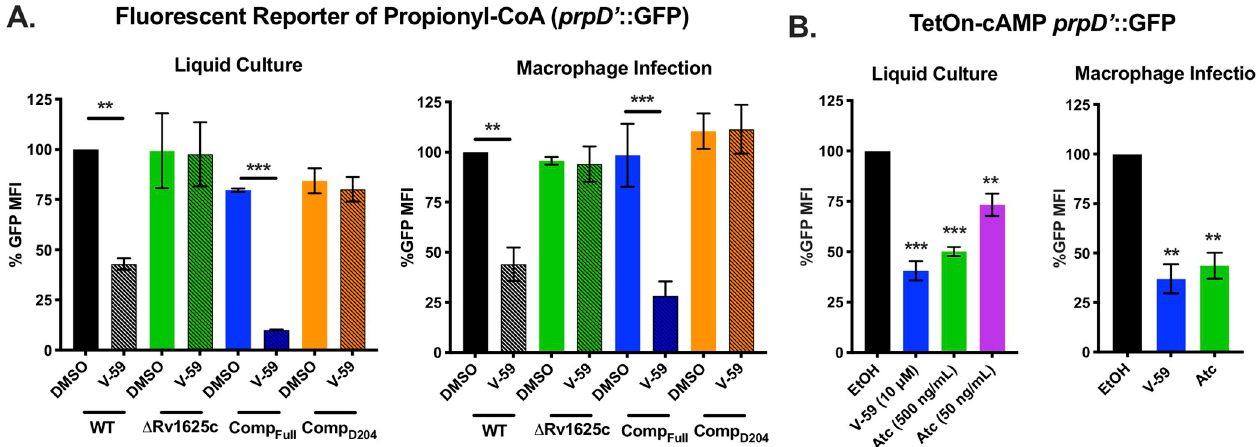
Fig 7. Activating cAMP synthesis decreases liberation of propionyl-CoA from cholesterol. ( A ) Relative GFP signal from the prpD’ ::GFP reporter in response to V-59 (10 μ M) or DMSO treatment in murine macrophages or cholesterol media. Data are normalized to WT treated with DMSO ( �� P < 0.01, ��� P < 0.001, Two-way ANOVA with Tukey’s multiple comparisons test). ( B ) Relative GFP signal from the prpD’ ::GFP reporter in response to inducing TetOn-cAMP with Atc treatment in murine macrophages or cholesterol media. Data are normalized to EtOH vehicle control ( �� P < 0.01, ��� P < 0.001, One- way ANOVA with Dunnett’s multiple comparisons test). GFP MFI was quantified from 10,000 mCherry + Mtb. Data are from two experiments with two technical replicates, shown as means ± SD.